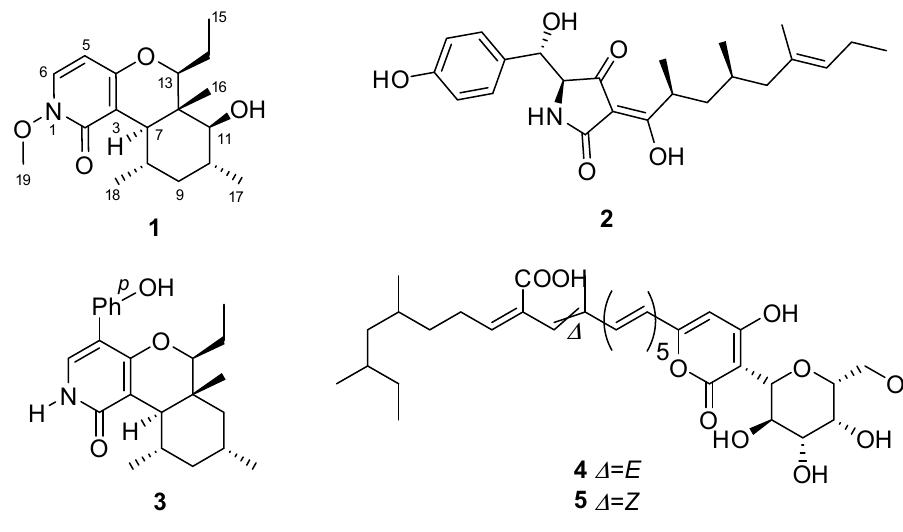
Figure 2. Structures of compounds 1 – 5 .